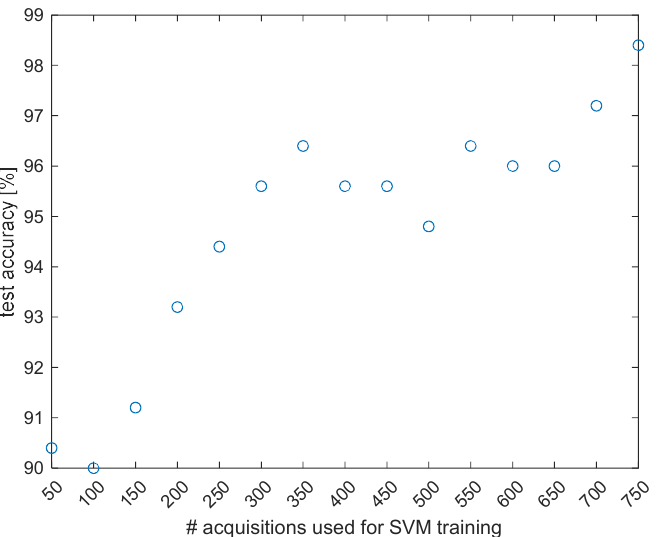
Figure 4. Standard deviation of the ϕ-OTDR signal amplitude as a function of the fiber position.